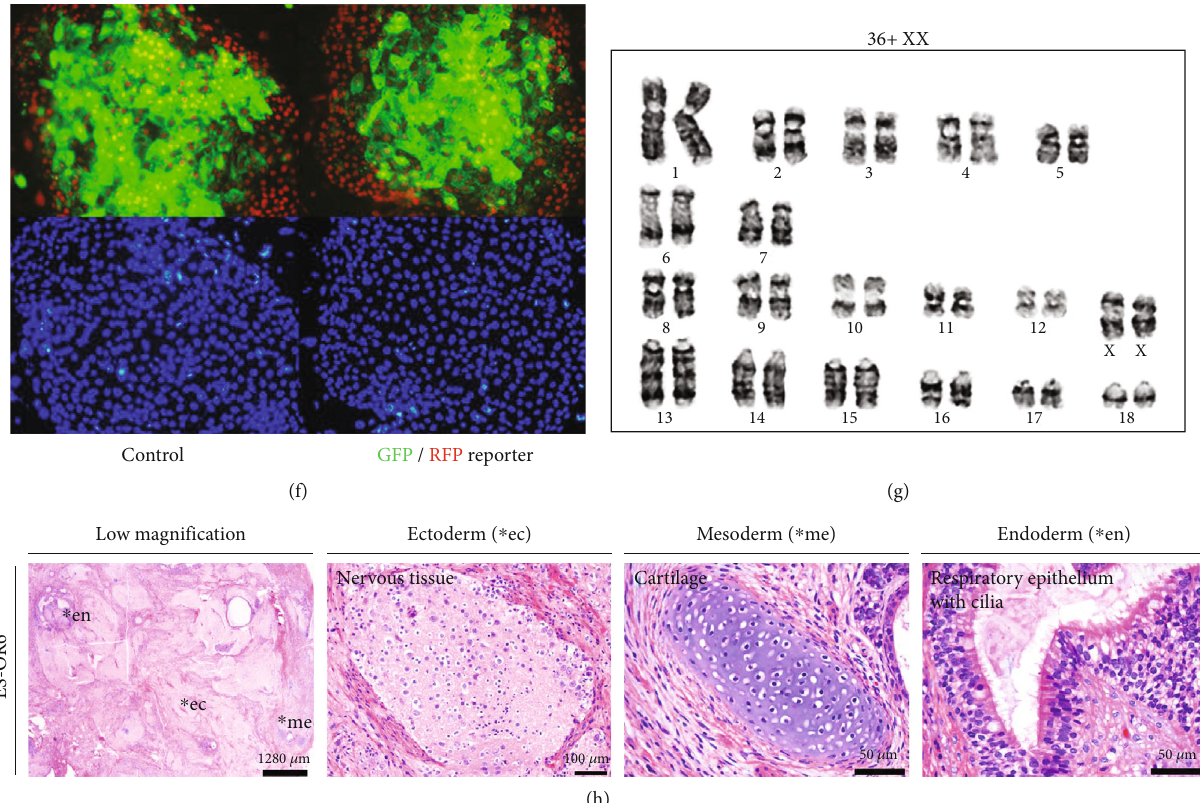
Figure 3: Characterization of porcine embryonic stem cells with the porcine OCT4 reporter system. (a) Porcine embryonic stem cells with the OCT4 reporter system. (b) Embryoid bodies aggregated from porcine embryonic stem cells. (c) Comparison of gene expression related to pluripotency between undi ff erentiated embryonic stem cells and di ff erentiated embryoid bodies. (d) Comparison of gene expression related to di ff erentiation between undi ff erentiated embryonic stem cells and di ff erentiated embryoid bodies. (e) SSEA4 and OCT4. (f) SSEA1 and SOX2 in porcine embryonic stem cells with or without the OCT4 reporter system. Pluripotency markers such as OCT4 and SOX2 and surface markers such as SSEA1 and SSEA4 coexpressed in pig embryonic stem cells with or without OCT4 reporter system. (g) Karyotyping of porcine embryonic stem cells with the OCT4 reporter system. Karyotyping showed that no chromosomal aberration occurred during in vitro culture. (h) Teratoma assay of porcine embryonic stem cells with the OCT4 reporter system. When injected subcutaneously into athymic nude mice, stem cells could generate into teratoma containing all three germ layers, such as nervous tissue, cartilage, and